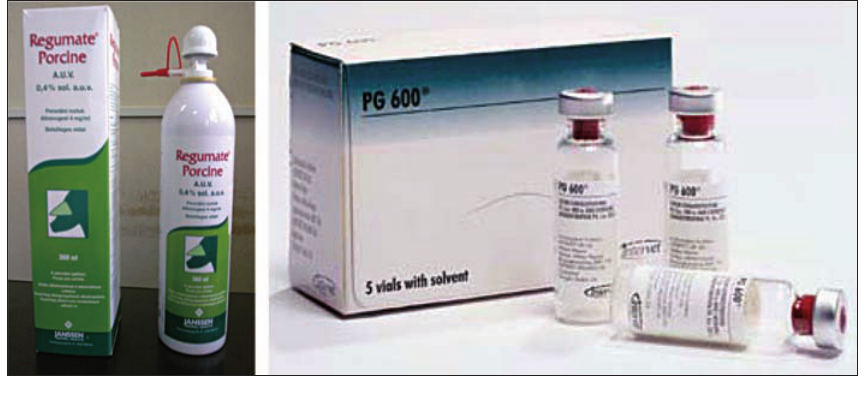
Fig. 1. The hormonal products